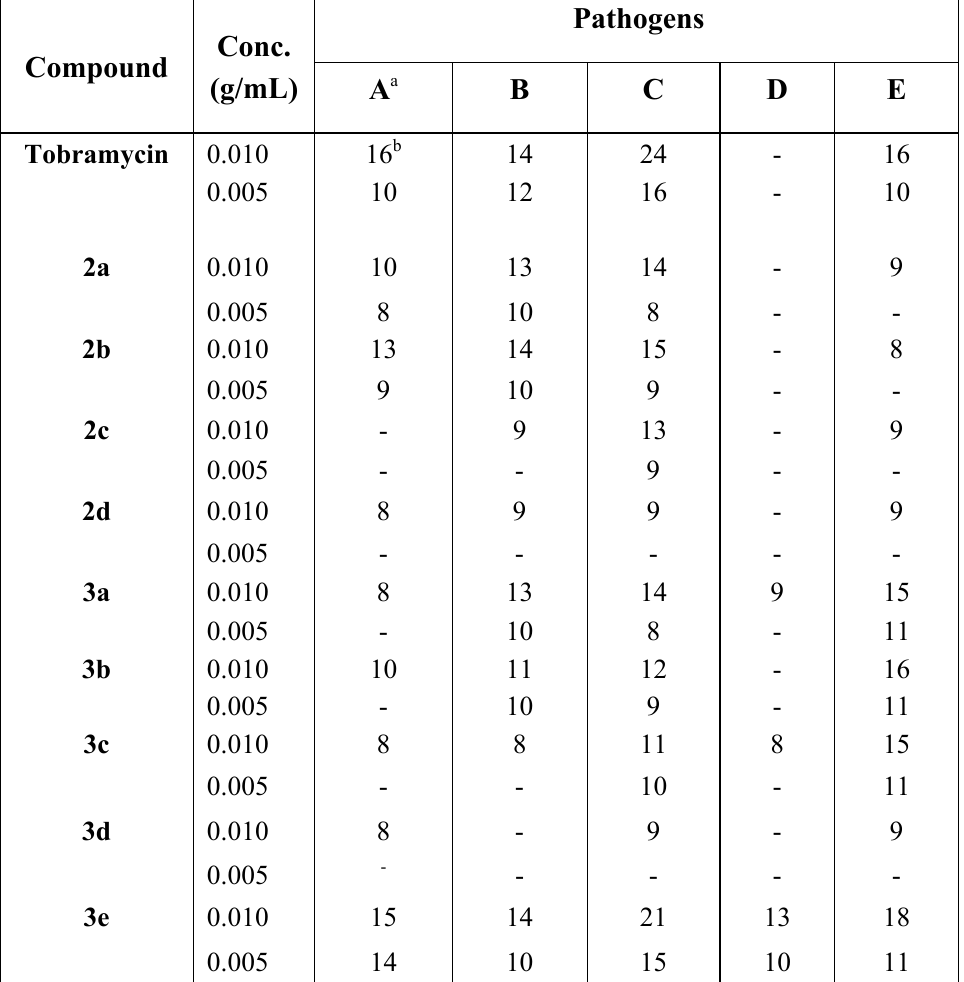
Table 2. Sensitivity of human pathogenic microbes to the new synthetic heterocyclic compounds using the filter paper disk